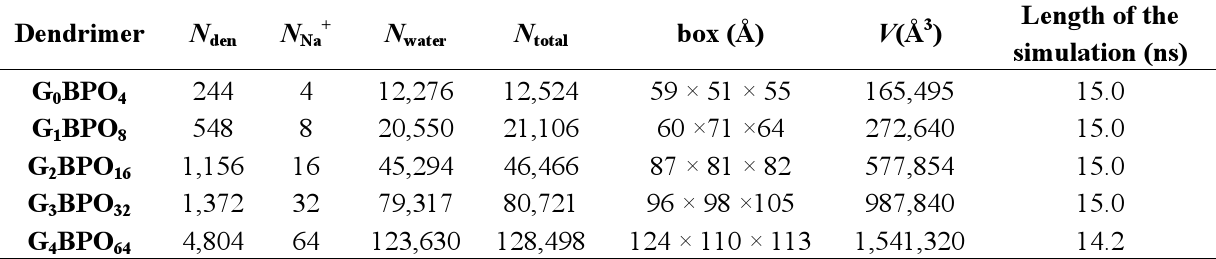
Table 6. Properties of dendrimers and simulation details ( N respectively, the number of atoms in the dendrimer, of sodium ions, of atoms in water molecules and the total number of atoms. V is the initial periodic box volume. Dendrimer